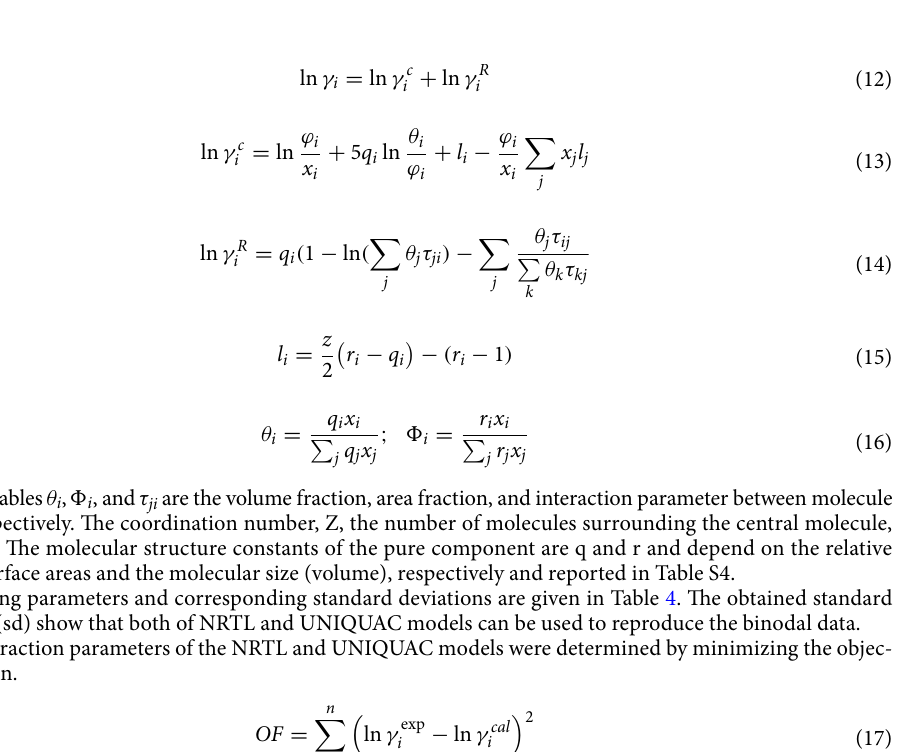
Correlations of the partition coefficients. For modeling of experimental partition coefficients of